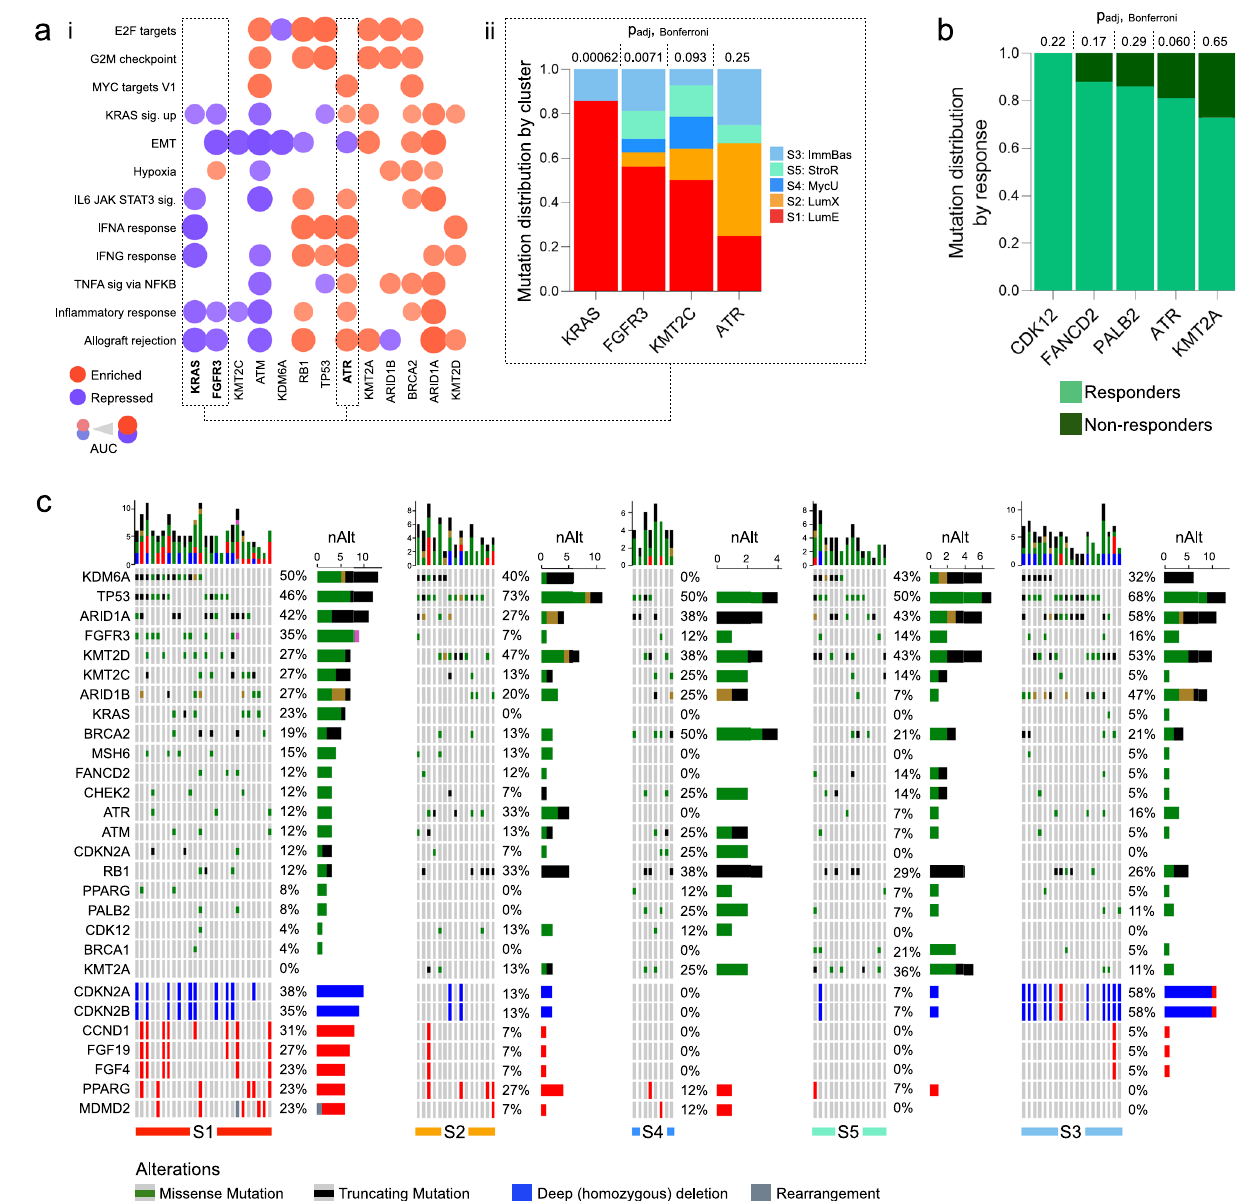
Fig. 3 | Somatic mutations and copy number alterations in CPI-MIBC PURE-01 expression subtypes. a Dotplot (left, i): Hallmark gene-set analysis for PURE01 tumors with mutations in 13 selected genes (relative to WT). Barplot (right, ii): fraction of samples in a subtype with somatic mutations in KRAS, FGFR3, KMT2C, or ATR. Exact p adj , given for each gene, were calculated as follows. P -values were calculated using two-sided Pearson ’ s chi-square tests, and were Bonferroni-correctedformultiplecomparisons. b Relativemutationfrequency of fi ve selected genes, strati fi ed by response (CR or PR; non-response is NR). P -values were calculated using two-sided Pearson ’ s chi-square tests, and were